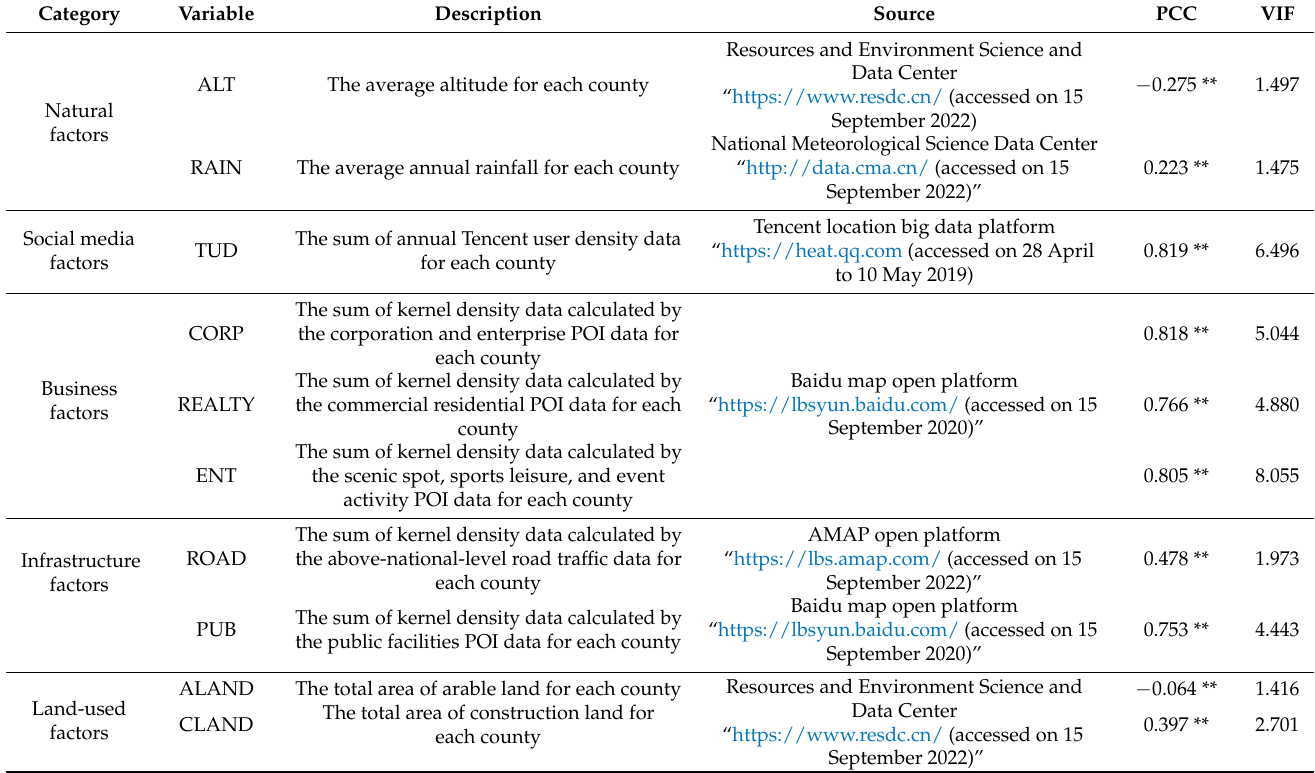
Table 1. Independent variable descriptions and their correlation with county